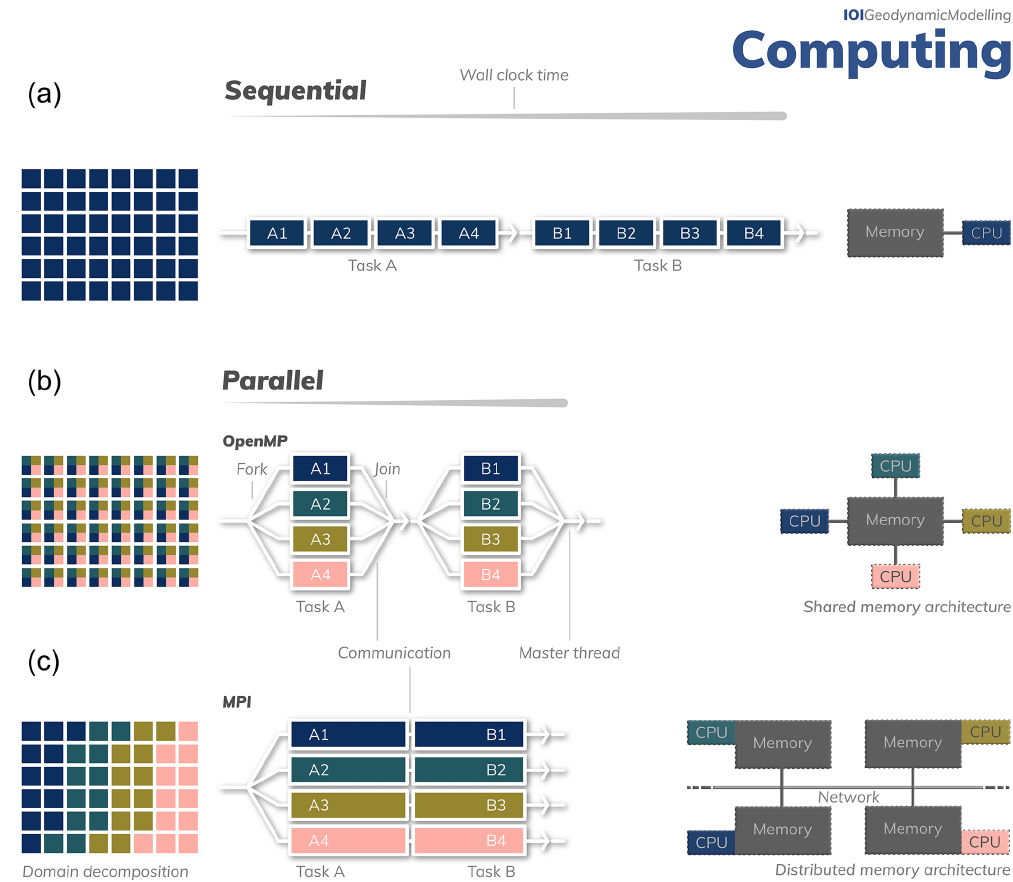
Figure 6. Computation paradigms. (a) Sequential programming with the discretised domain shown on the left. The code performs two tasks, A and B, in a sequential manner on a single thread which has access to all of the computer’s memory. (b) The same code executed in parallel relying on OpenMP. Each processor of the computer concurrently carries out a part of tasks A and B so that the compute wall-clock time is smaller. (c) If relying on MPI-based parallelisation the domain is usually broken up so that each thread “knows” only a part of the domain. Tasks A and B are also executed in parallel by all the CPUs, but now there is a distributed architecture of processors and memory interlinked by a dedicated